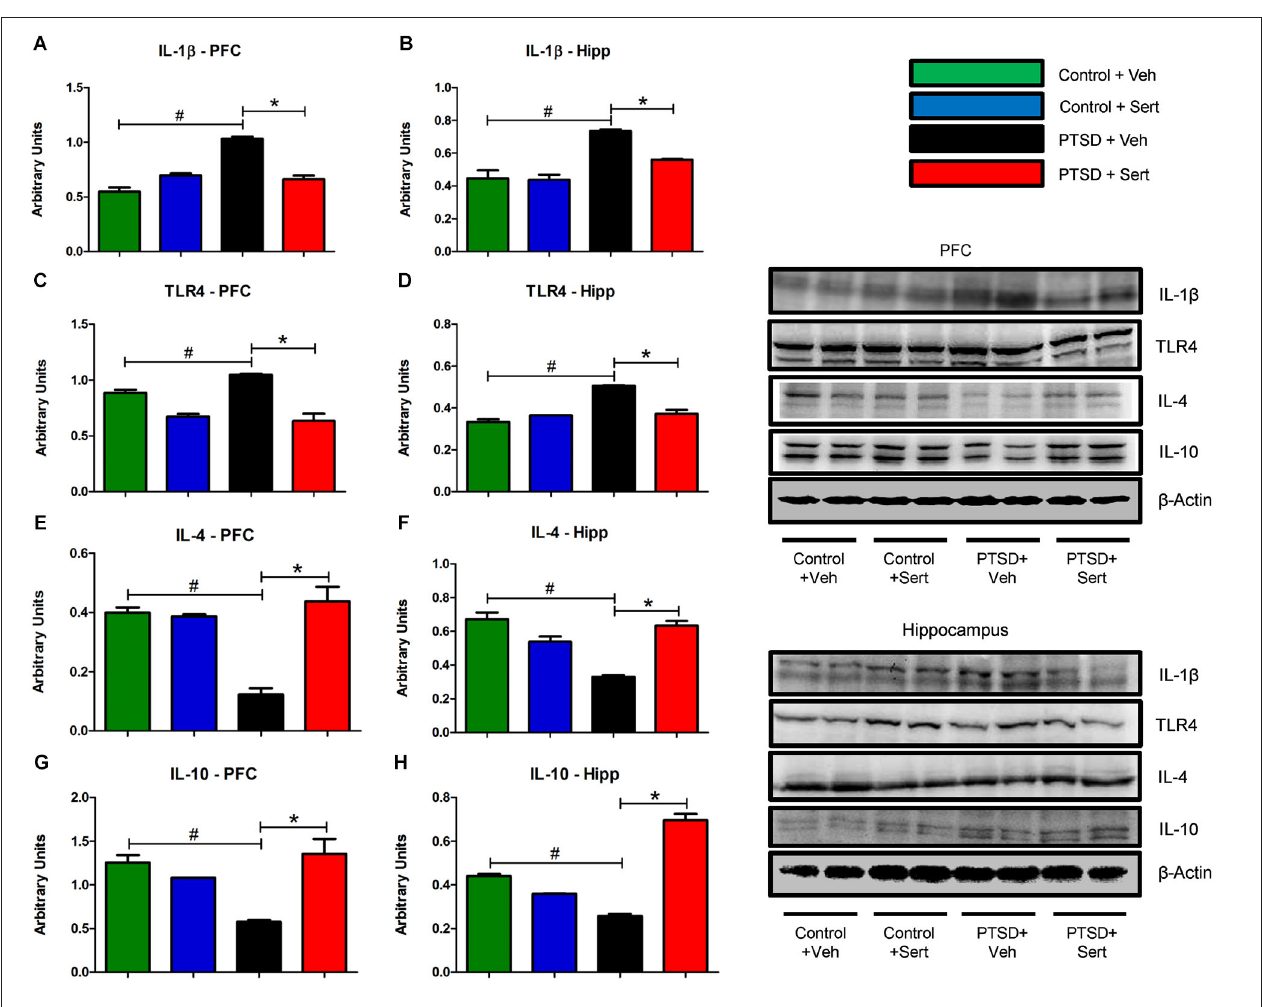
H ). Sertraline administration also normalized the aberrant protein to levels similar as the control + Veh group. All data are presented as mean ± SEM. * p < 0.05 between the PTSD groups. # p < 0.05 between the vehicle